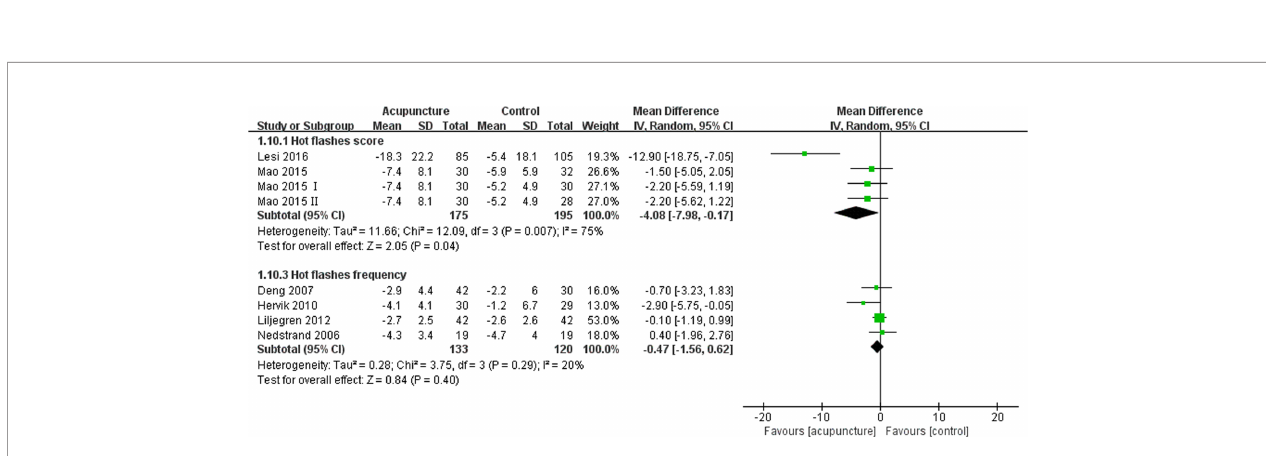
FIGURE 2 | Forest plot of the change of pain in BC patients treated with acupuncture and control from the bassline to end of treatment. (A) Pain measured by Brief Pain Inventory-Short Form; (B) Pain measured by Visual Analogue Scale. IV, inverse variance; CI, Con fi dence Interval. The Roman numerals “ I ” followed the study ID represented the comparison of acupuncture versus no intervention in the study which had three arms.